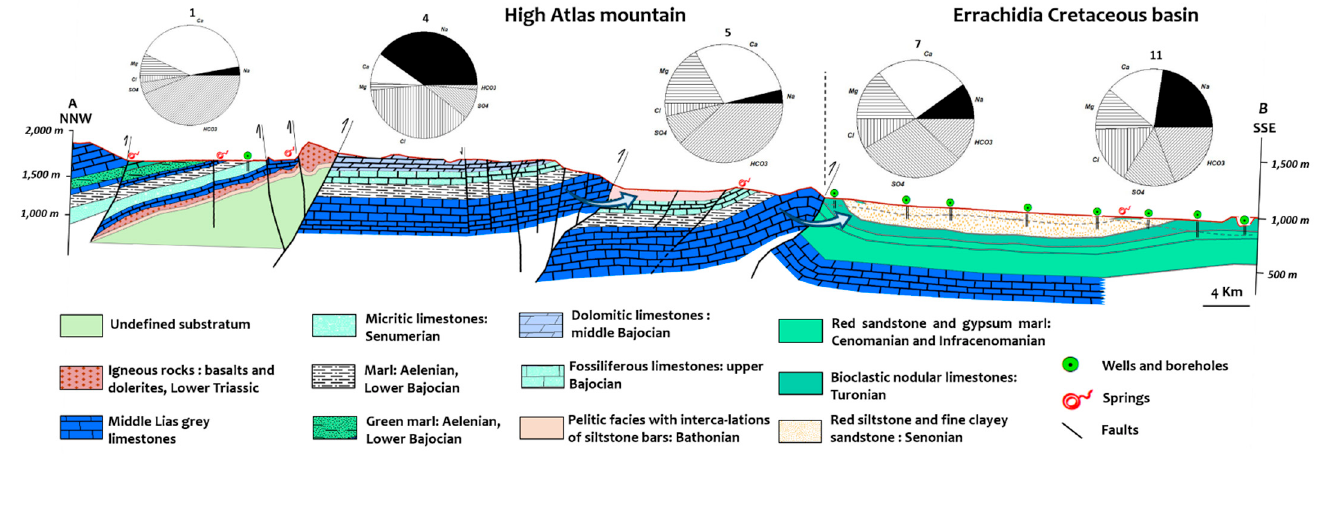
( b ) Figure 10. ( a ) Plot of δ 18 O vs. electrical conductivity. ( b ) Plot of δ 18 O vs. nitrate concentration . 4. Geological Validation Our geological study focused on the Cretaceous basin formations and those of the High Atlas separated by the South Atlas thrust. This thrust is constituted by a succession of faults generally oriented in a WSW-ENE direction. These faults put the permeable formations located on both sides of this structural limit in direct contact, as is the case in